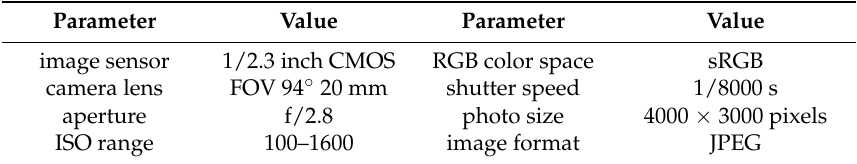
Table 1. The detailed parameters of the camera of DJI phantom3